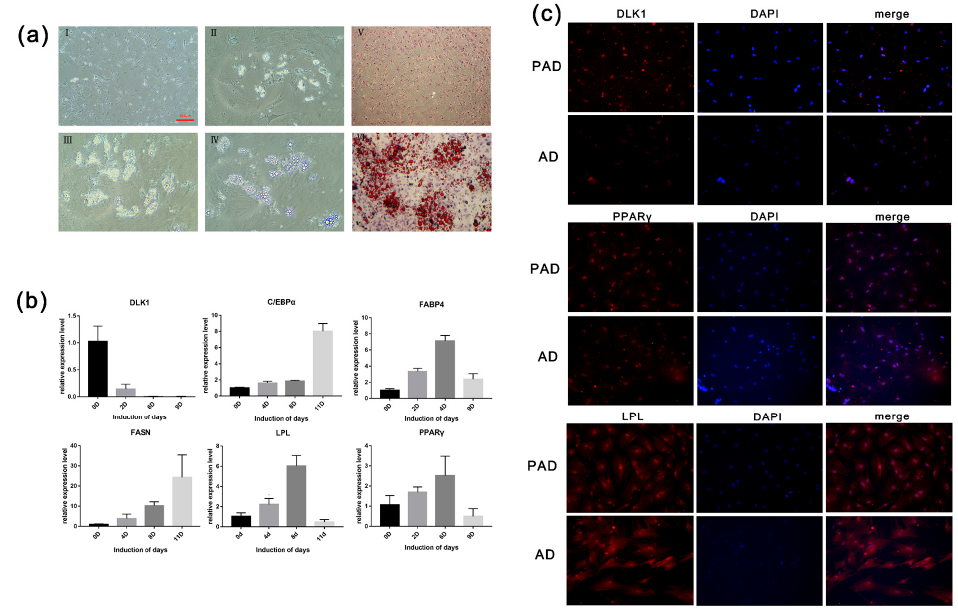
Figure 2. ( a ) Oil Red O staining of preadipocytes and adipocytes; ( b ) The mRNA expression levels of the marker genes of preadipocytes and adipocytes; ( c ) Immunofluorescence staining of preadipocytes